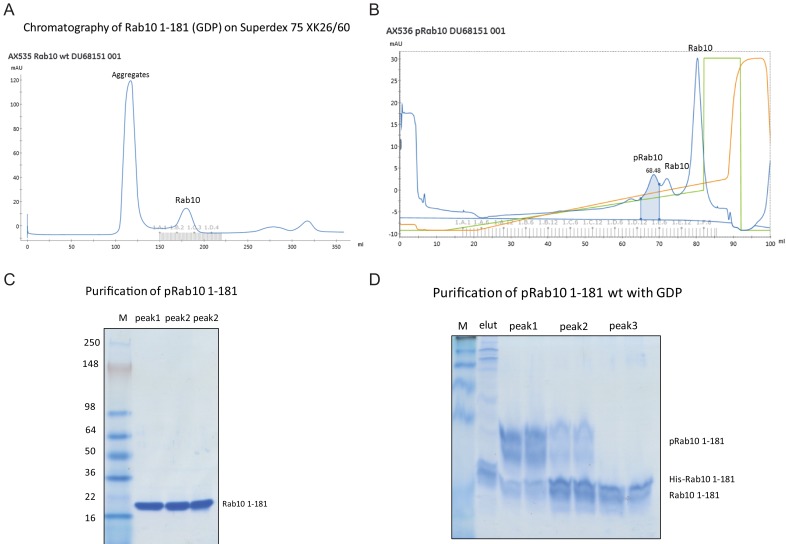
Purification and characterization of Thr73 phosphorylated Rab10[1-181].(A) Chromatogram (UV280nm) of Rab10 1-181, separated on a Superdex 75 XK 26/60 column to obtain monomeric protein. Equipment: Äkta Pure. Evaluation Software: Unicorn 7.1. Monomeric Rab10 eluted at 180.03 ± 10 ml. (B) Chromatogram (UV280nm) of phosphorylated Rab10 1-181 (wild-type, wt with GDP), separated on a Source 15 S HR10/10 column. Equipment: Äkta Pure. Evaluation Software: Unicorn 7.1. Phospho-Rab10 eluted at 68.48 ± 2 ml. (C) Coomassie stained 4-20% gradient SDS polyacrylamide gel electrophoresis analysis of the purification of phospho-Rab10 1-181 (wt in GDP). Lane M = See-Blue Plus Marker (Invitrogen); peak1 = first peak from a 10 ml Source S column containing phospho-Rab10 1-181. Peak2 = second peak from a 10 ml Source S column containing Rab10. Peak3 = third peak, containing Rab10. (D) Coomassie stained 12% Phos-tag SDS polyacrylamide gel electrophoresis analysis of the purification of pRab10 1-181 (with GDP). Lane M = See-Blue Plus Marker (Invitrogen); Lane elut = His-Rab10 eluted from Ni-agarose; peak1 = first peak from a 10 ml Source S column containing phospho-Rab10 1-181. Peak2 = second peak from a 10 ml Source S column containing mostly Rab10. peak3 = third and major peak of the Source S column (unphosphorylated Rab10).